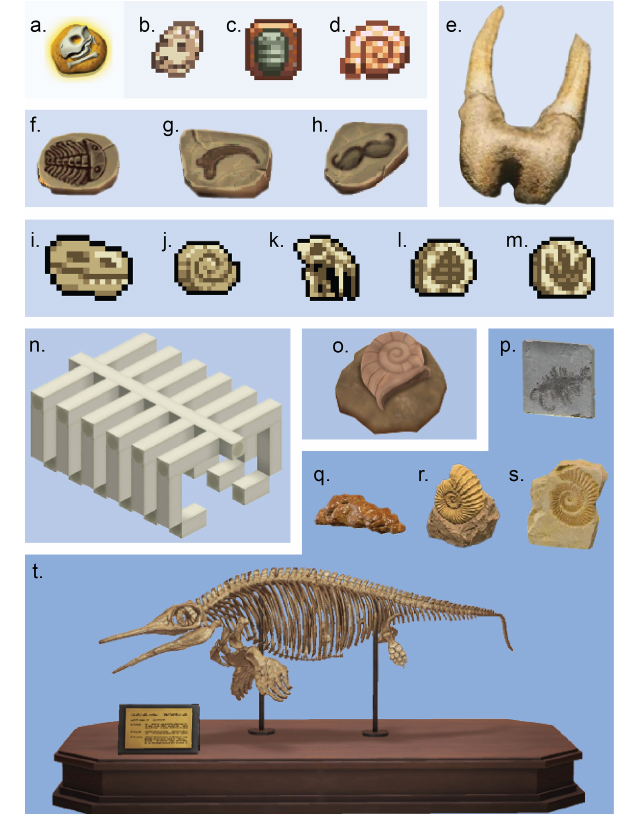
Figure 4. Examples of fossil collectibles in COTS video games. (a) “Generic fossil”. (b) Prehistoric skull (described in game as a ground sloth skull). (c) Trilobite. (d) Nautilus Fossil. (e) Dinosaur bone (note: this is a walrus skull). (f) “Enormous Trilobite”. (g) Raptor Claw. (h) “Perfectly Preserved Moustache”. (i) T. rex skull. (j) Ammonite. (k) Sabretooth skull. (l) Fossil Fern. (m) Footprint Fossil. (n) Fossil Rib Cage. (o) Helix fossil. (p) Anomalocaris . (q) Coprolite. (r) Ammonite (s) Shark-tooth pattern (note: this is a He- licoprion tooth “whorl”) (t) completed Ophthalmosaurus skeleton consisting of two collectibles – Ophthalmosaurus skull (which in- cludes the front flippers and anterior section of the ribcage) and the Ophthalmosaurus torso (consisting of posterior ribs, hind flip- pers, and tail section). Video games: (a) : No Man’s Sky (2016, Hello Games). (b–d) : Stardew Valley (2016, ConcernedApe). (e) : Red Dead Redemption 2 (2018, Rockstar Games). (f–h) : The Sims 4 (2014, Maxis). (i–m) : Starbound (2016, Chucklefish). (n) : Minecraft (2011, Mojang). (o) : Pokémon series (1999, Gamefreak). (p–t) : Animal Crossing: New Horizons (2020, Nintendo EAD).